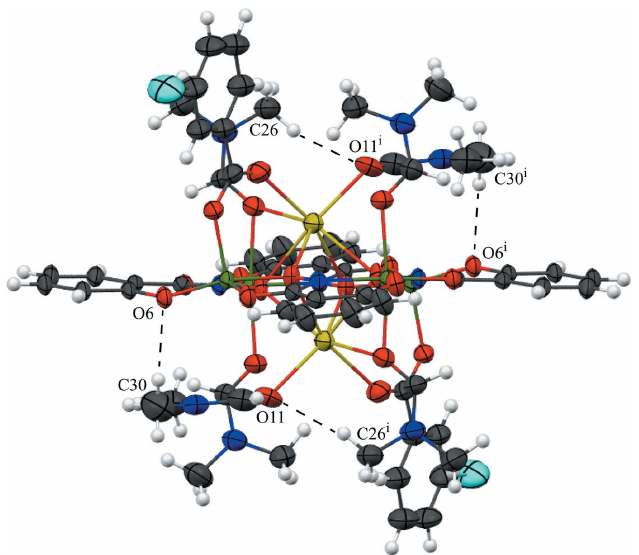
Figure 3 Intramolecular C—H (cid:2)(cid:2)(cid:2) O interactions in 1 between the hydrogen atoms (white) of the methyl groups of the coordinated DMF molecules and the MC [symmetry code: (i) (cid:3) x + 1, (cid:3) y + 1, (cid:3) z + 1]. For clarity the disorder has been omitted and only the atoms involved in the hydrogen bonding have been labeled. See Fig. 1 for additional display details.